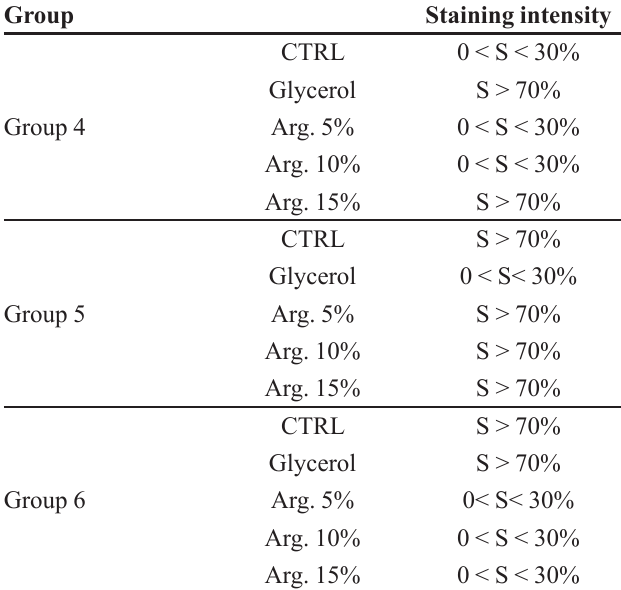
TABLE II - Evaluation of collagen fibers stained in male mouse skin Group Staining